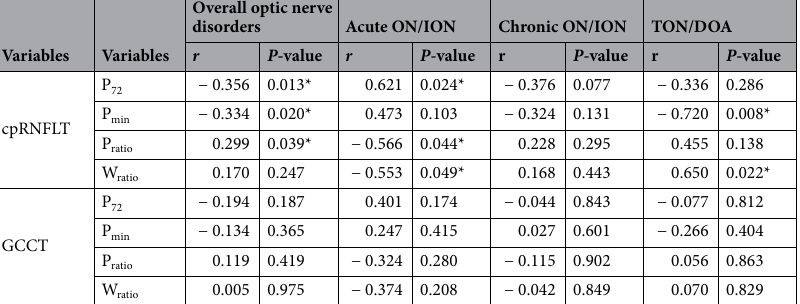
Table 3. Univariate analysis between PhNRs and cpRNFLT, GCCT in optic nerve disorders. cpRNFLT, circumpapillary retinal nerve fiber layer thickness; GCCT, ganglion cell complex thickness; ON, optic neuritis; ION, ischemic optic neuropathy; TON, traumatic optic neuropathy; DOA, dominant optic atrophy. * P < 0.05 was considered significant.